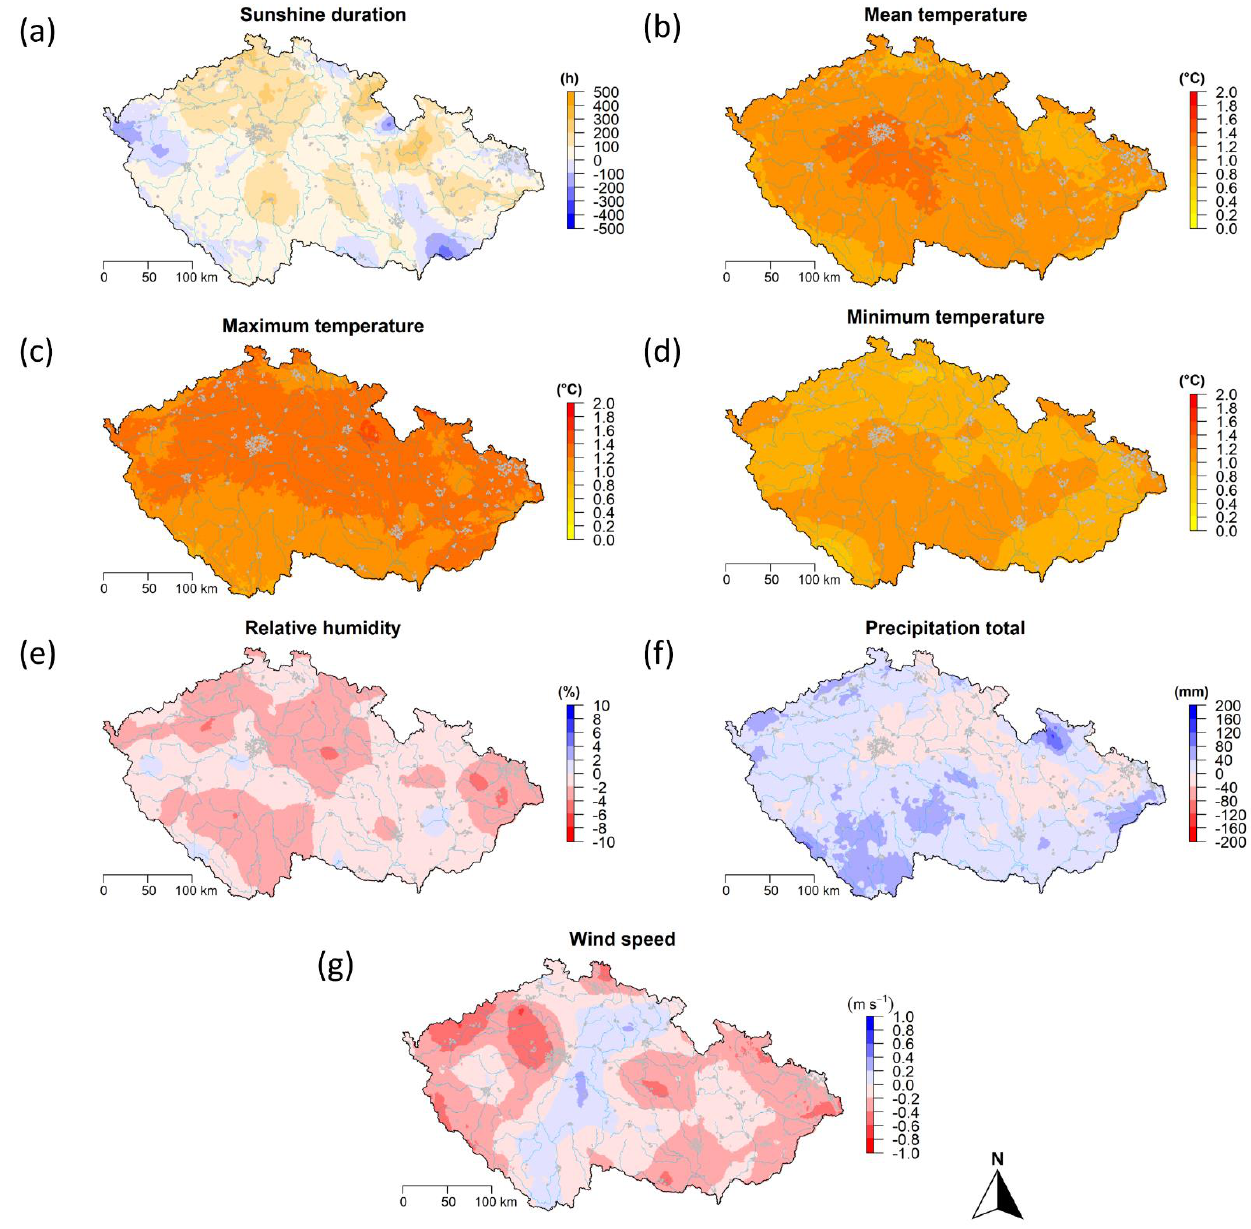
Figure 12. Spatial distribution of differences between the 1991–2020 and 1961–1990 periods over the territory of the Czech Republic for the annual series of selected climate variables: ( a ) sunshine duration, ( b ) mean temperature, ( c ) maximum temperature, ( d ) minimum temperature, ( e ) relative humidity, ( f ) precipitation total, and ( g ) wind speed. The individual maps were created based on the number of stations specified in Section 2.2.